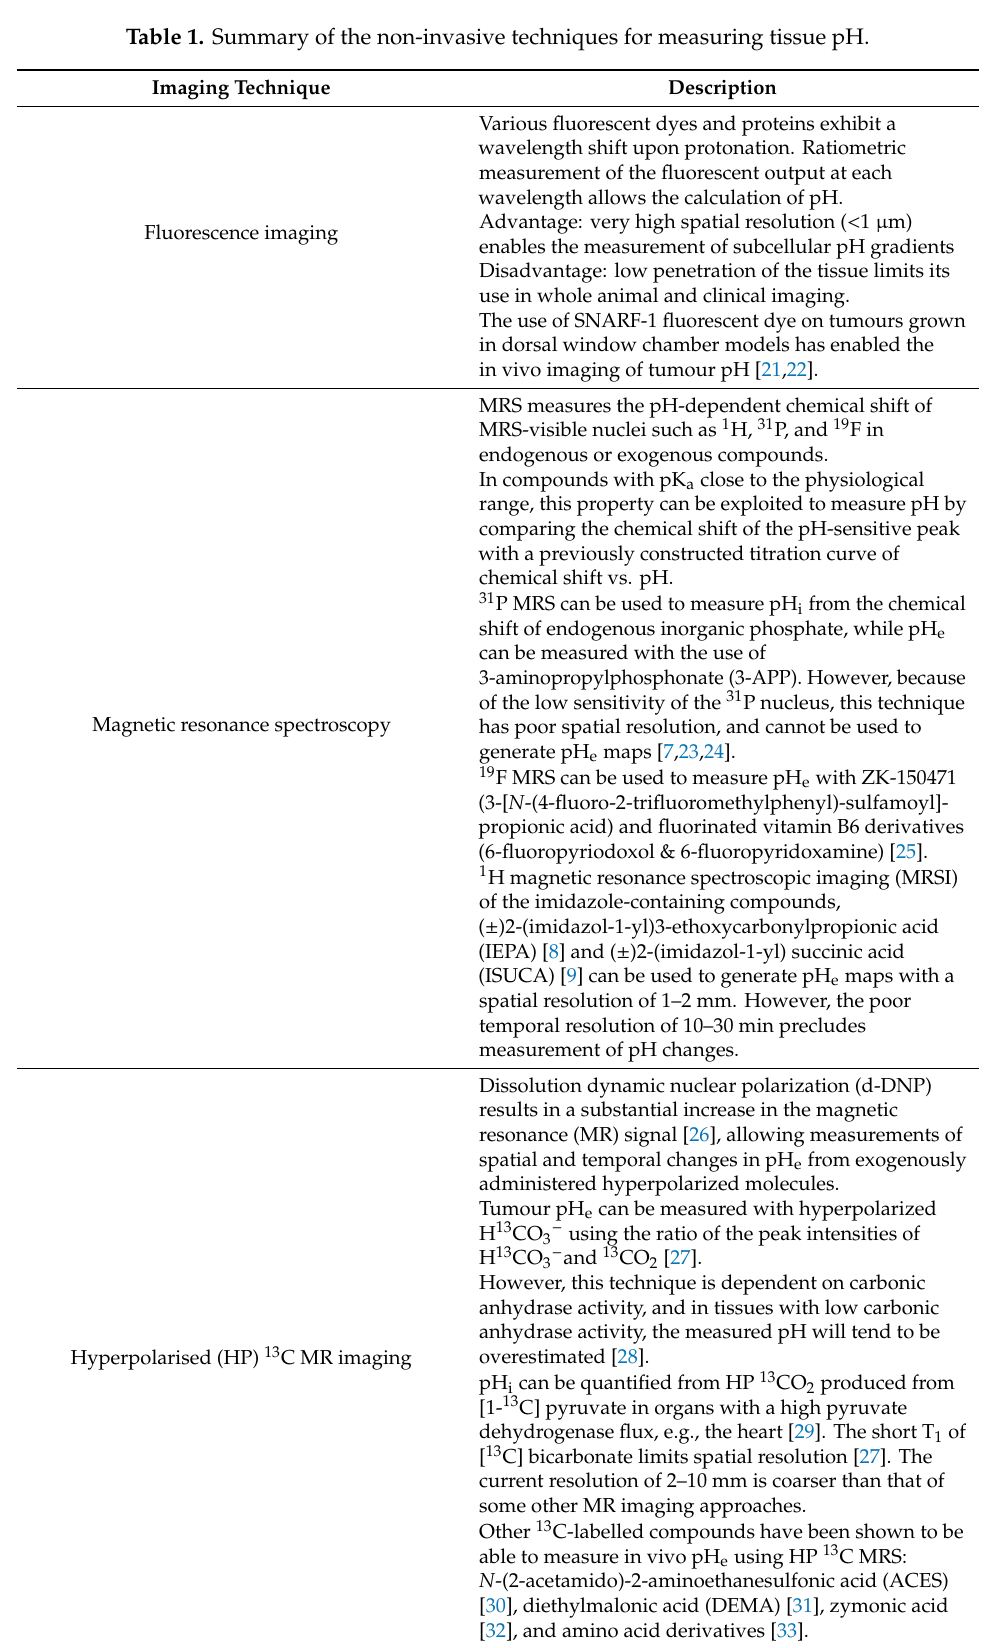
Table 1. Summary of the non-invasive techniques for measuring tissue